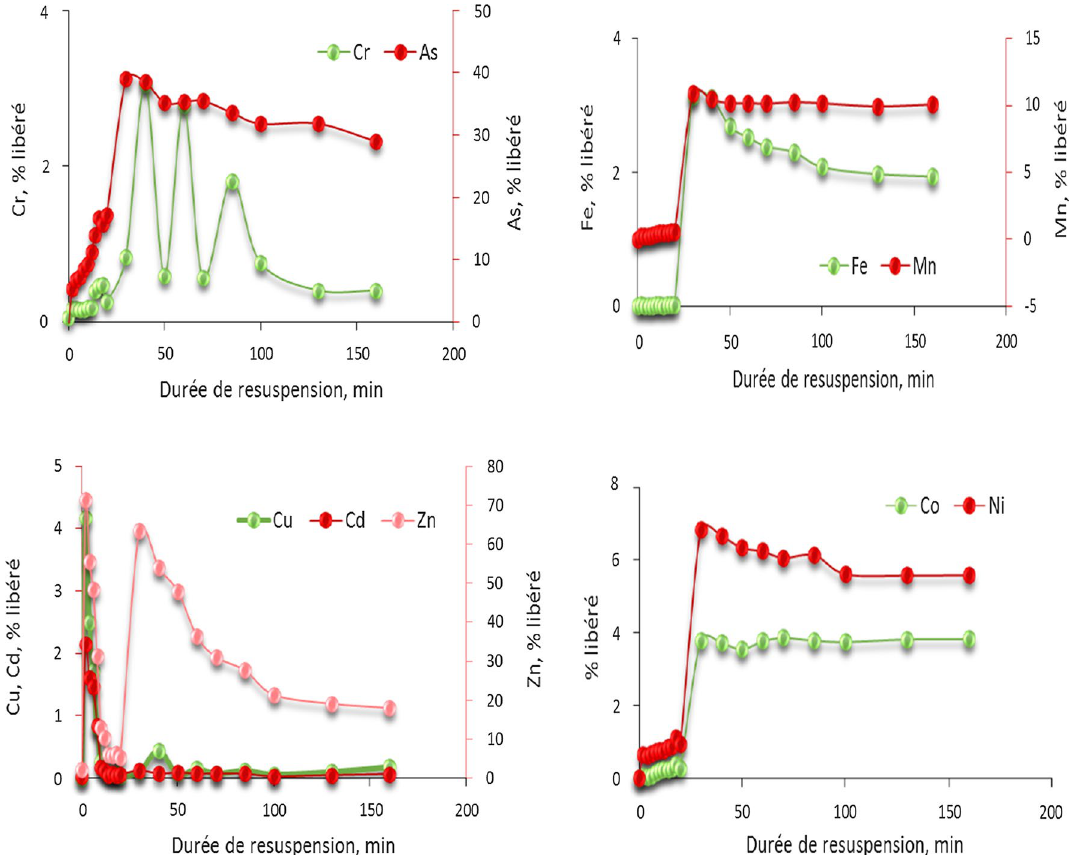
Fig. 4 Mobilization percentage (%) EMT during the kinetics of mobilization of the sediment under reductive conditions in nitrogen atmosphere and pH